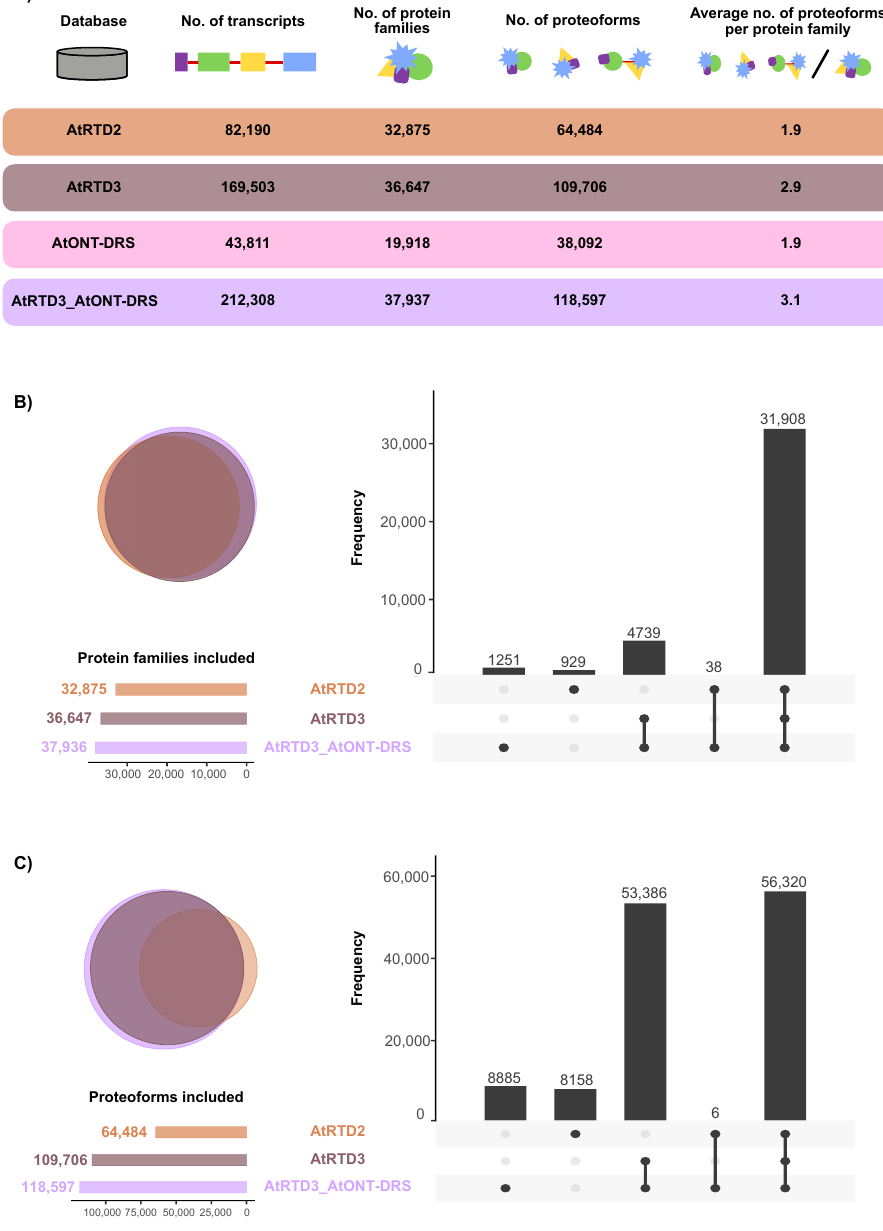
Figure 1. Overview of the different protein databases used in this study. ( A ) Number of transcripts, proteoforms and average proteoforms per protein family in each database. ( B ) Venn diagram and UpSet plot showing the overlap between the protein families included in the different protein databases used in this study. ( C ) Venn diagram and UpSet plot showing the overlap between the proteoforms included in the different protein databases used in this